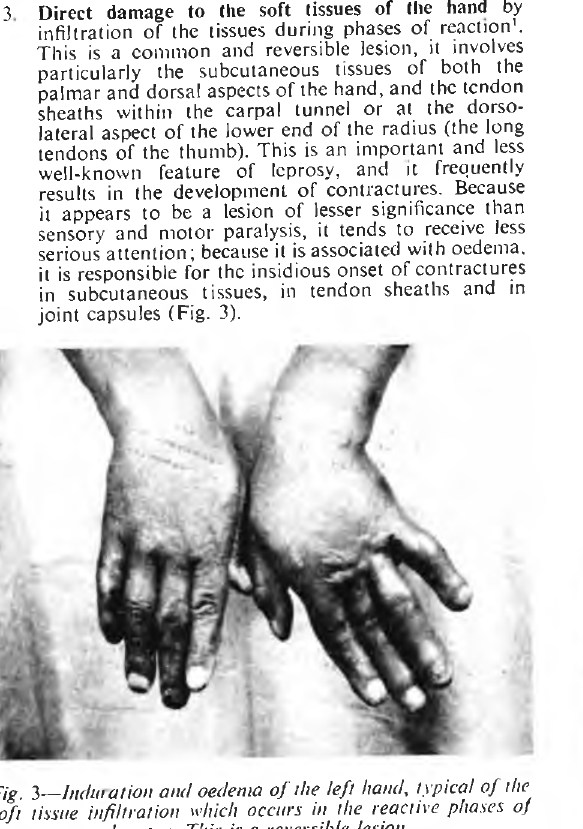
fig 4 — The deformity which occurs in the feel as a result o f I the paralysis o f the foot intrinsic muscles. Vesicidation and ulceration cue common concomitant